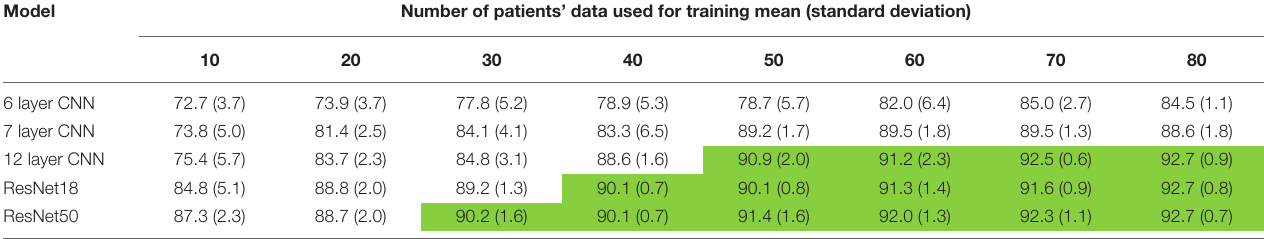
FIGURE 10 | F 1 score and test accuracy of CNN and ResNet models trained with data from increasing numbers of patients. Convolutional neural networks (CNN) and ResNet models were tested on expert labeled electrocorticographic (ECoG) records from 80 patients. A dotted line is drawn at F 1 score value of 90% for reference.